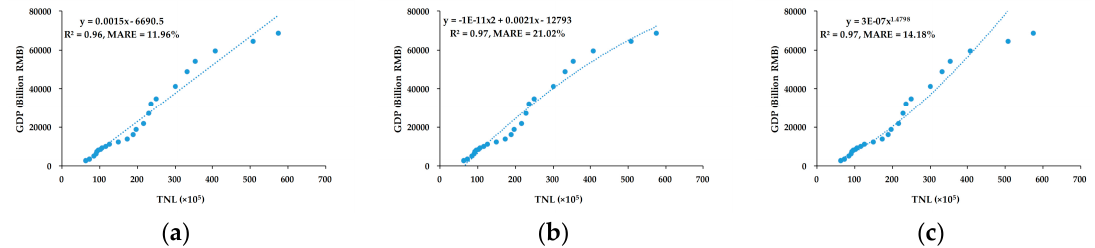
Figure 3. Regression models between the statistical GDP data and TNL from extended temporal coverage data in time series at the country level from 1992 to 2015: ( a ) the linear model; ( b ) the quadratic polynomial model; ( c ) the power function model.